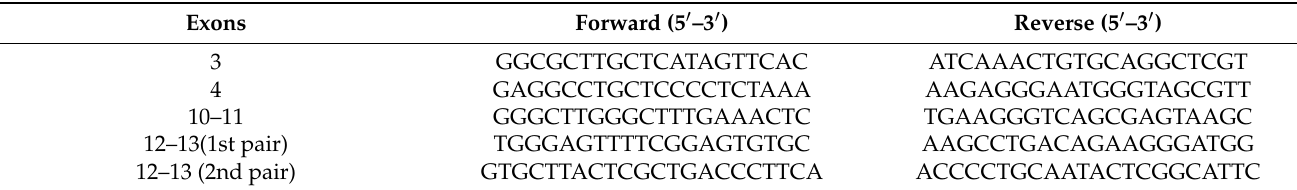
Table 5. Primers for genomic DNA amplification and sequencing of exons 3, 4 and 10–13 of the feline her2